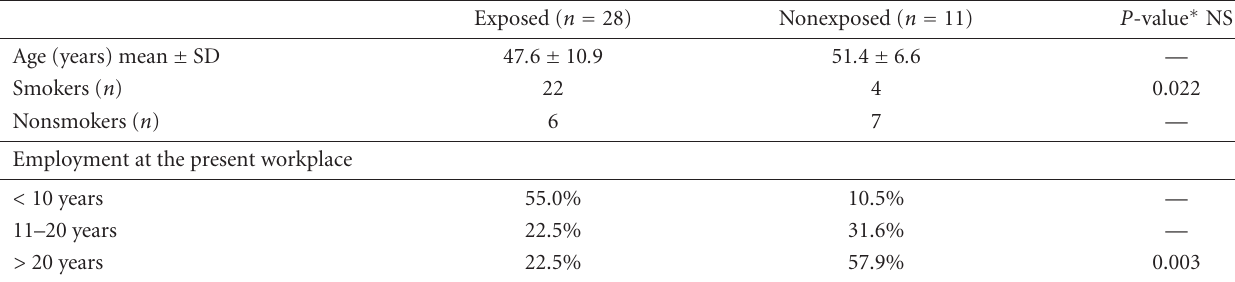
Table 1: Demographic and occupational parameters of the study participants.